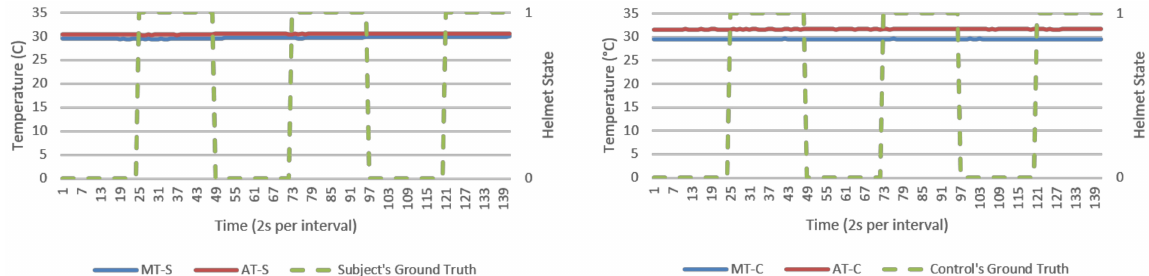
Figure 6. Temperature ( ◦ C) versus time (2 s per interval) data logs from a typical M run, human subject ( left ), and experiment control ( right ). Helmet state 0 = NW and 1 =